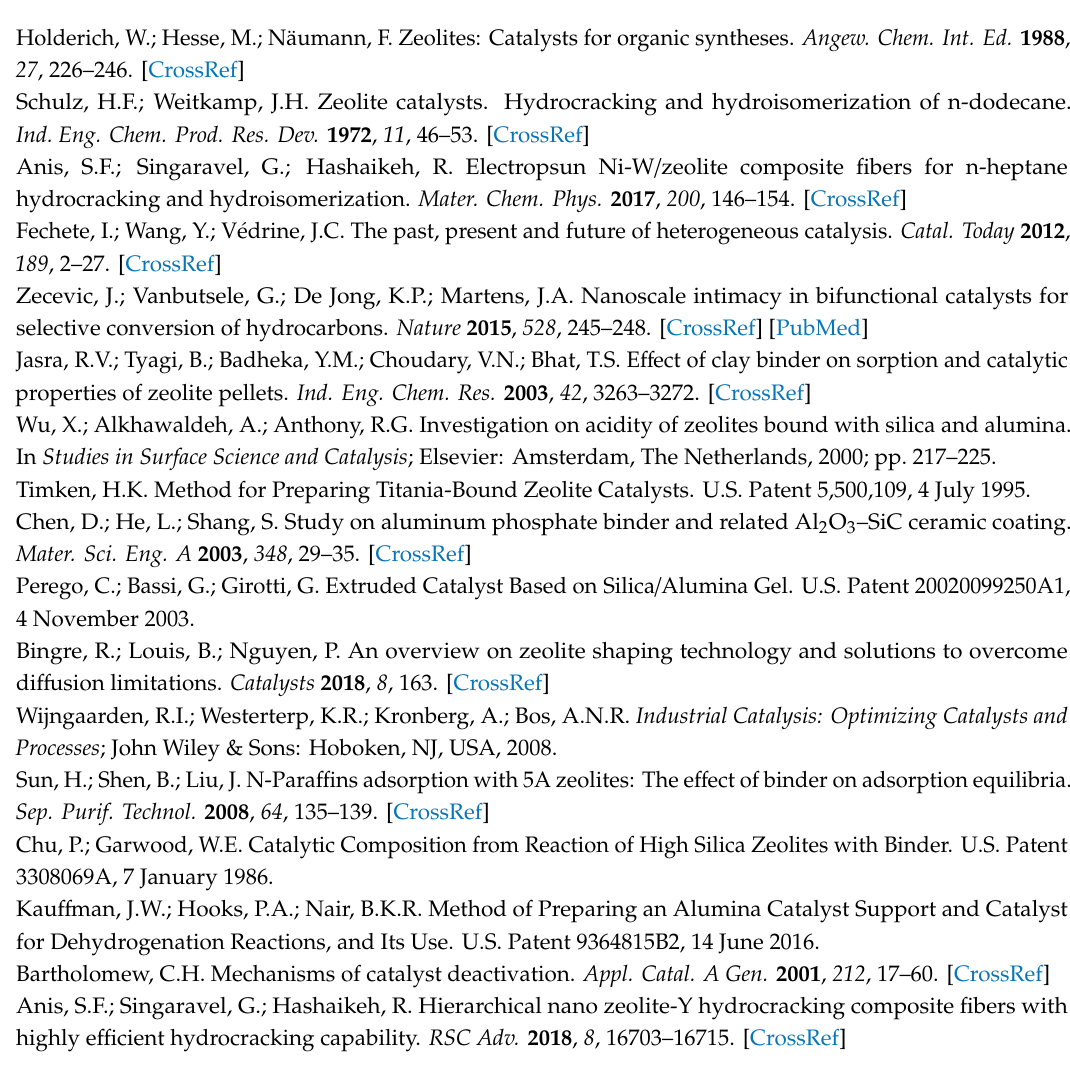
Figure S1: EDS analysis of an industrial hydrocracking catalyst extrudate received from local refinery in Abu Dhabi, United Arab Emirates, Figure S2: TGA graph of CNS, Table S1: Para ffi ns Carbon number in of NHYZ / CNS and NHYZ catalysts, Table S2: Olefins Carbon number in of NHYZ / CNS and NHYZ catalysts, Table S3: Decomposition Temperature of